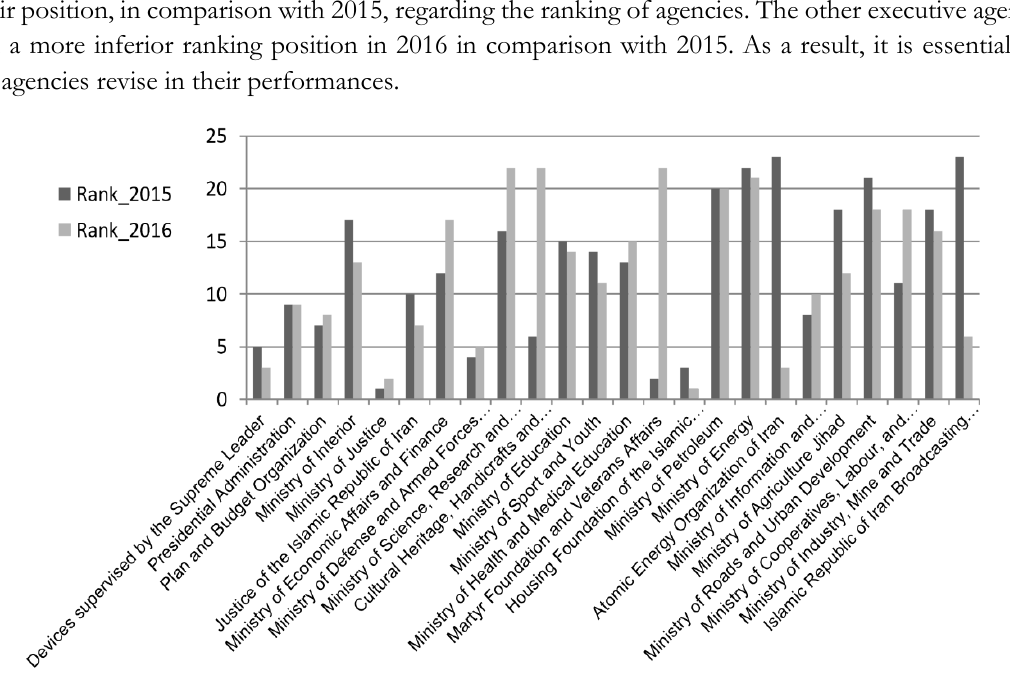
Fig. 1. A comparison of the ranking of the executive agencies in two varied years using the KHA model.